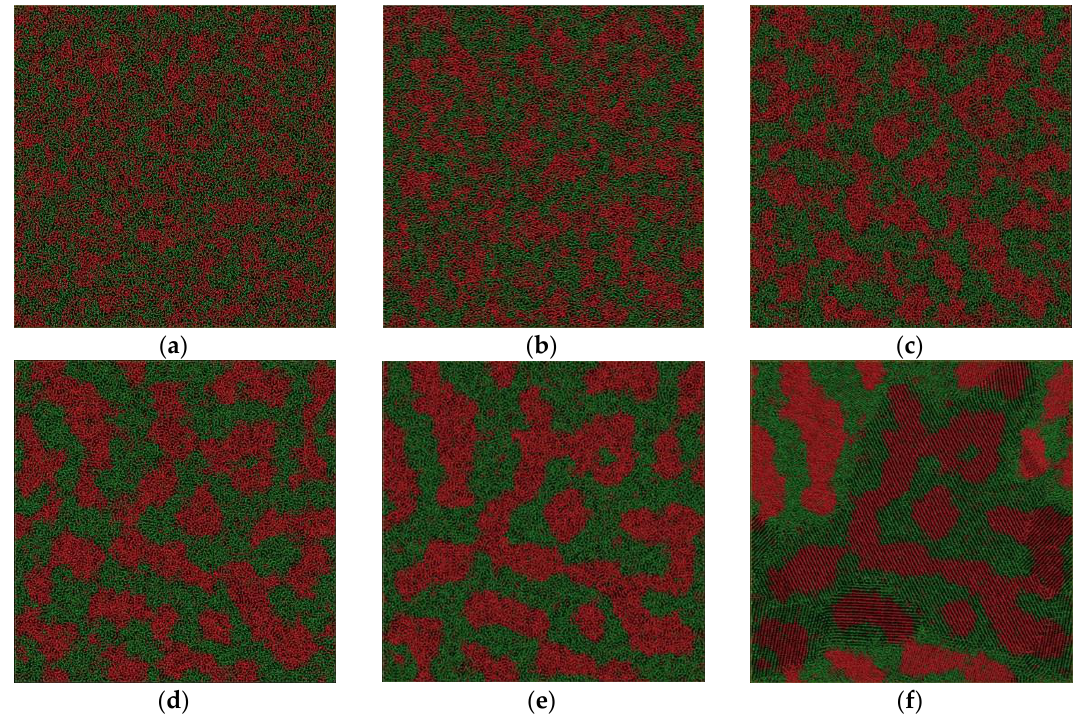
Figure 5. Atom snapshot of Fe 50 Cu 50 at different temperatures at the cooling rate of 6.4 × 10 11 K/s. ( a – f ) correspond to the atomic configuration at temperature of 2000 K, 1800 K, 1600 K, 1400 K, 1200 K, 1000 K, respectively.